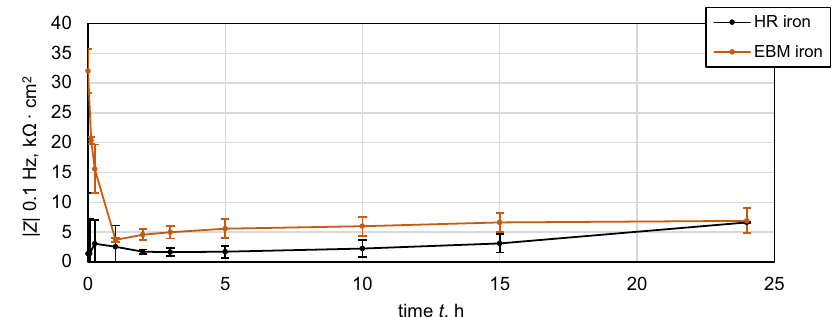
Fig. 10 Impedance values. Shown for both material states at 0.1 Hz as a function of the immersion time in